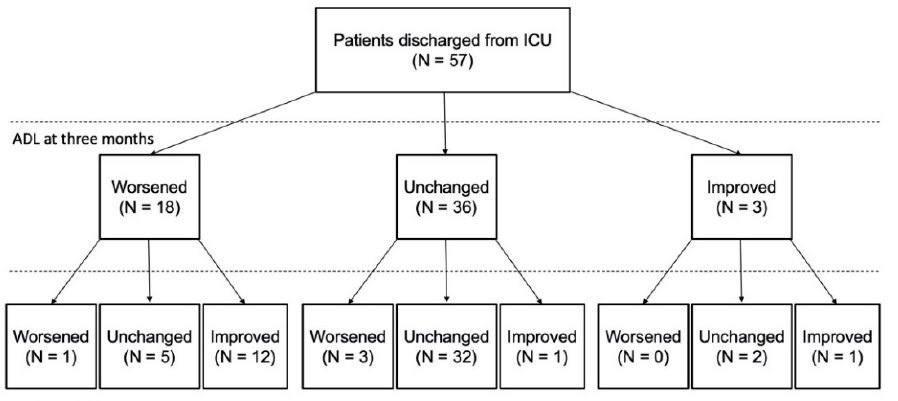
Figure 2. Trajectories of basic activities of daily living status within one year after intensive care unit discharge. We showed the trajectories of basic activities of daily living status (ADL) at three and twelve months after intensive care unit discharge. Worsened ADL was defined as a ≥ 10 decrease in Barthel index, and improved ADL was defined as a ≥ 10 increase in Barthel index from baseline to three months, or from three months to twelve months. The remainder of the patients were classified as unchanged. ICU: intensive care units; ADL: activities of daily living.